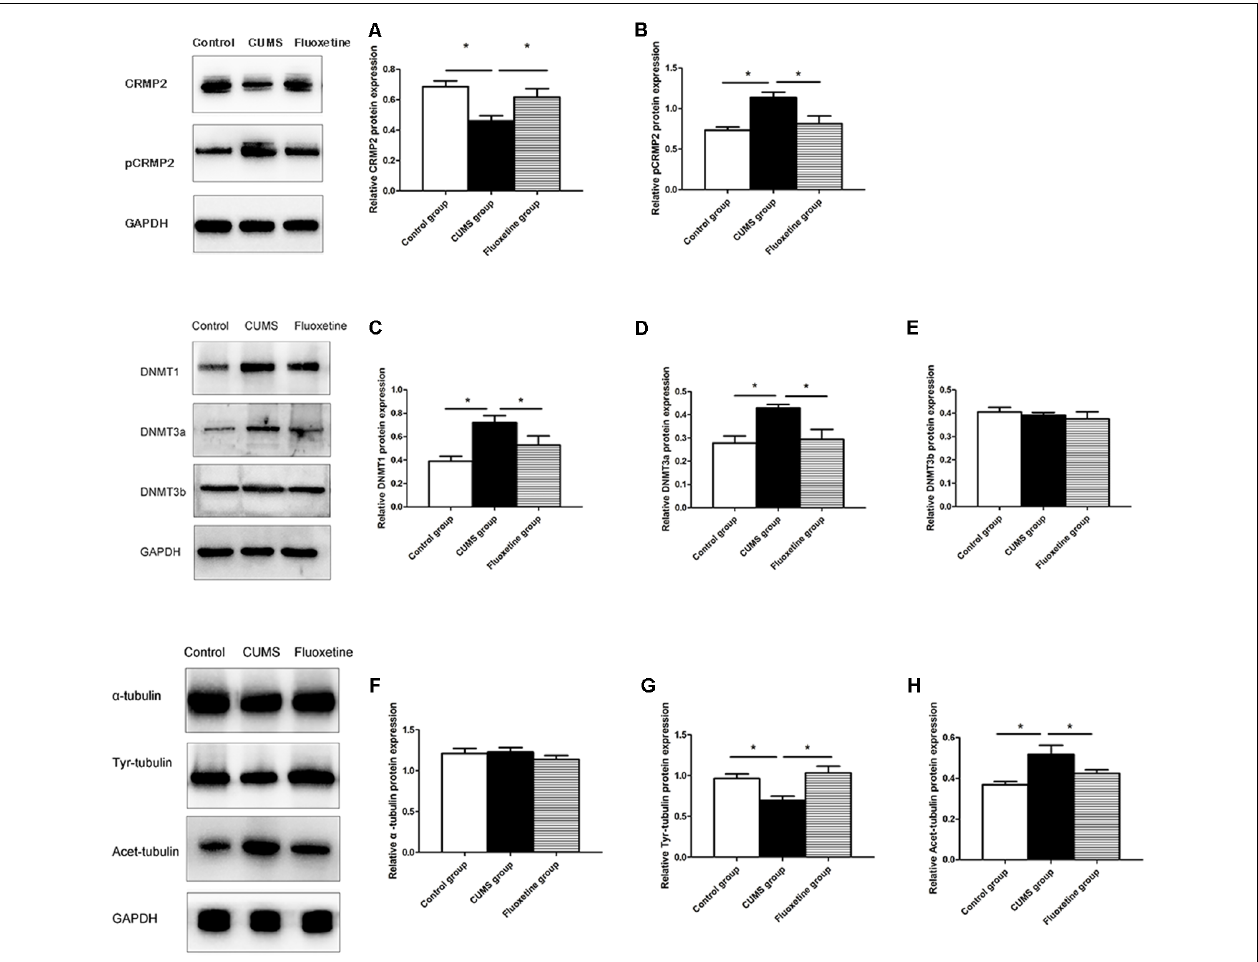
FIGURE 4 | Effect of CUMS and fluoxetine treatment on CRMP2 (A) , pCRMP2 (B) , DNMTs (DNMT1: C ; DNMT3a: D ; DNMT3b: E ), and α -tubulin isoform ( α -tubulin: F ; Tyr-tubulin: G ; Acet-tubulin: H ) expression in the hippocampus of rats. * P < 0.05.